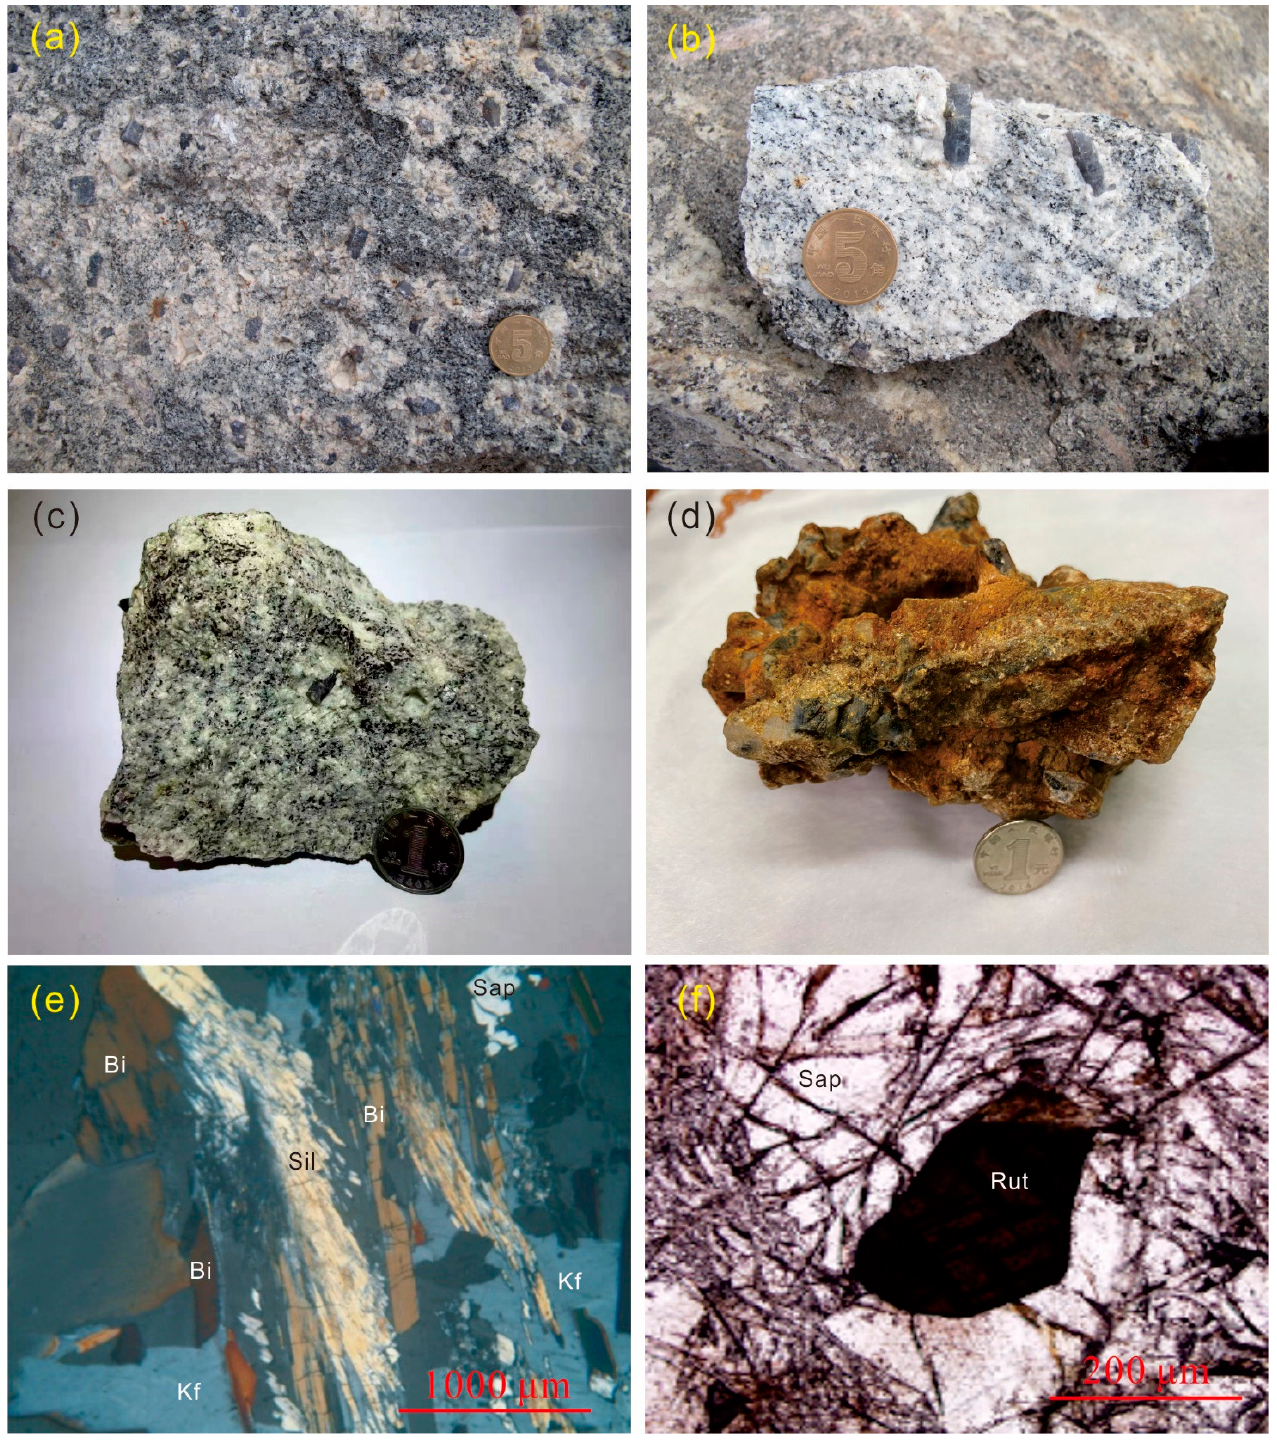
Figure 1. Occurrence features of the Fuping color-change sapphires. ( a , b ) Fuping sapphires occurring in granitic gneiss; ( c ) Fuping sapphire crystals exposed in biotite sillimanite gneiss; ( d ) Sapphire samples from the Mogok gneiss in Burma; ( e ) Microscopic picture of Fuping color-change sapphire (sample FU-3) showing the mineral assemblage of sapphire (Sap), sillimanite (Sil), biotite (Bi) and potassium feldspar (Kf); ( f ) A reddish-brown rutile (Rul) inclusion within Fuping color-change sapphire, sample FU-3.